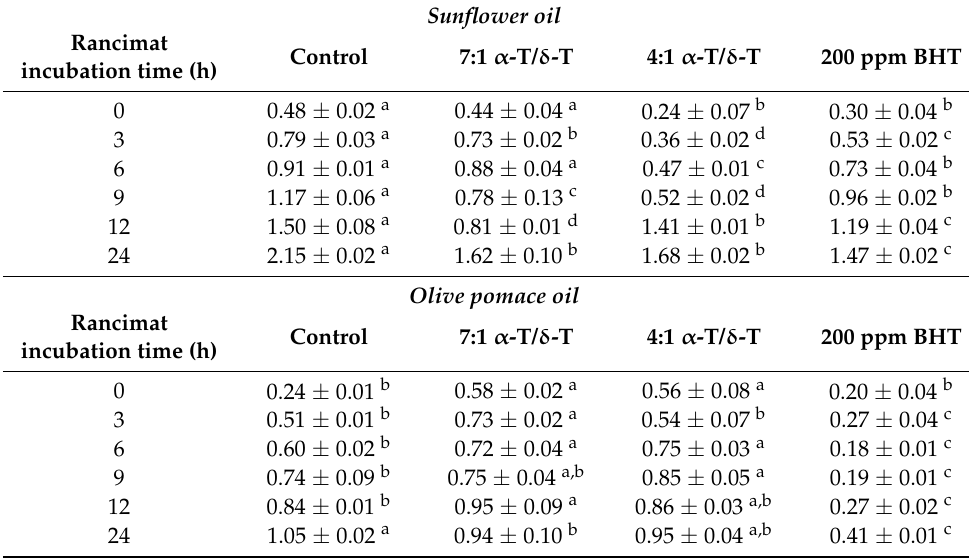
Table 6. TBARS values (mmoL MDAE/Kg Oil ± SD) of sunflower oil and olive pomace oil samples. Inside rows with a specific superscript letter (e.g., a–d) indicate a significant ( p < 0.05) difference for each Rancimat incubation time.